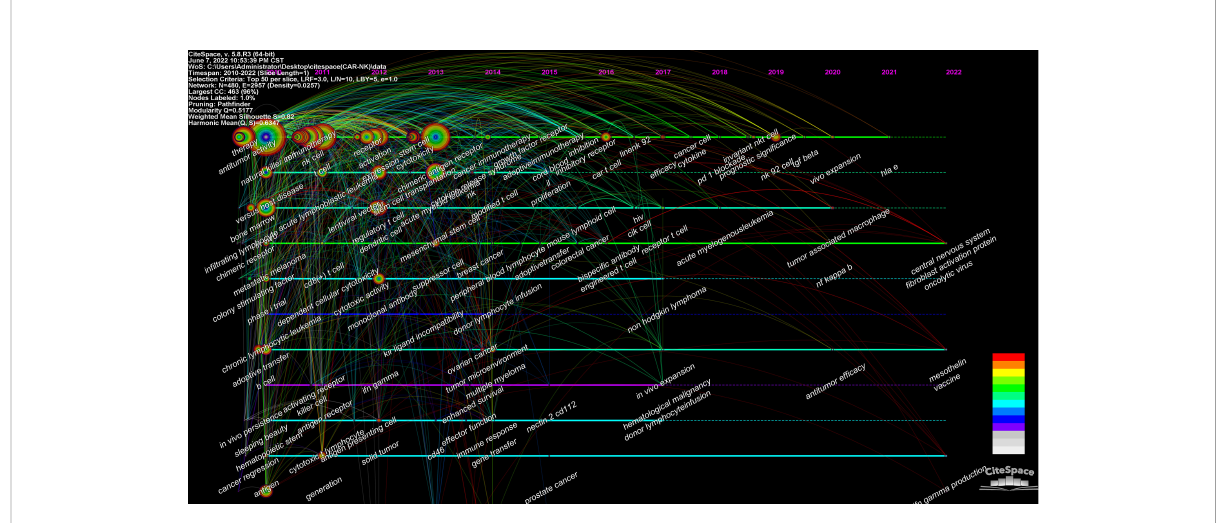
FIGURE 7 The timeline viewer of keywords involved in CAR-NK